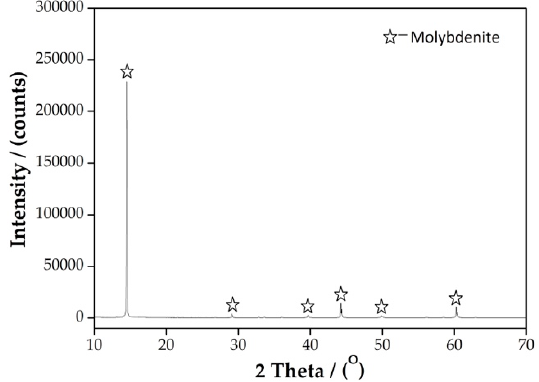
Figure 1. The result of XRD analysis of the purified molybdenite sample.